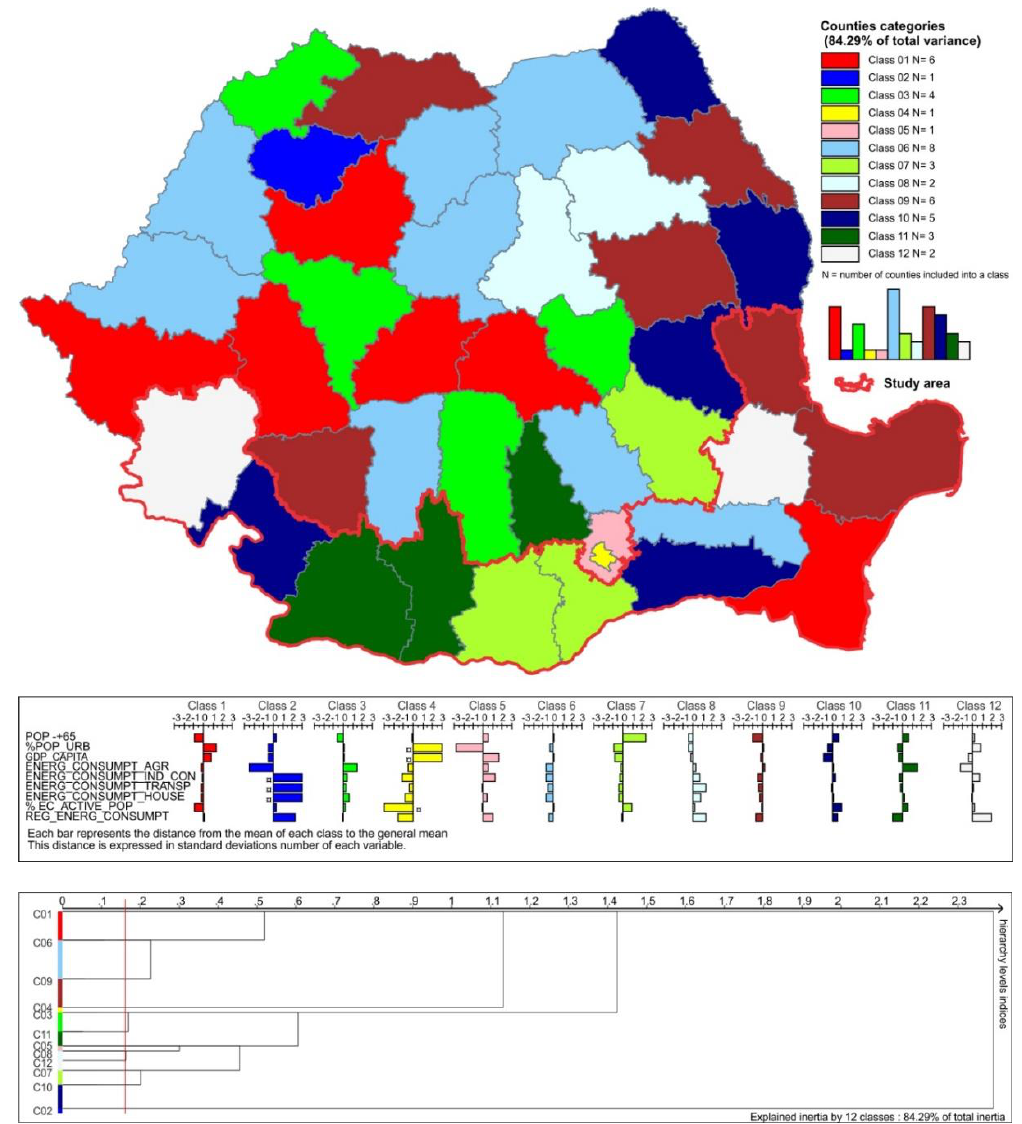
Figure 3. Spatial distribution of the demographic and economic indicators in 2000 (Source: TEMPO Online, National Institute of Statistics), (made with Philcarto, http://philcarto.free.fr).